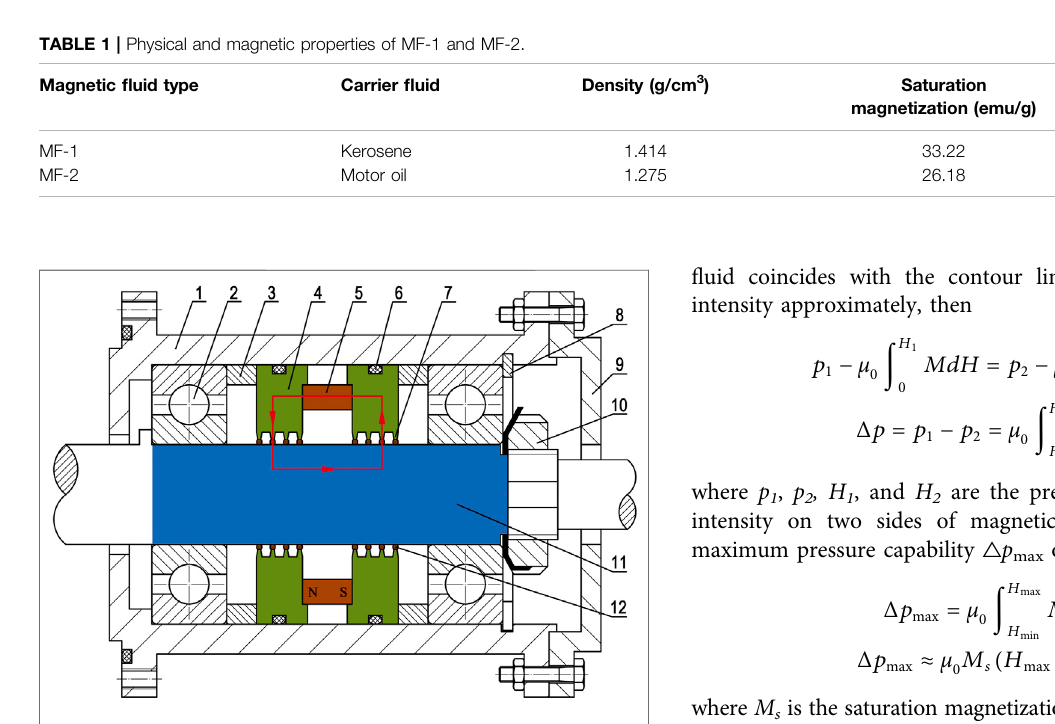
FIGURE2| SchematicrepresentationofatypicalMFSstructure(1-shell, 2-bearing, 3-sleeve, 4-pole piece, 5-magnet, 6-rubber ring, 7-pole tooth, 8- elastic collar, 9-end cover, 10-round nut, 11-shaft, and 12-magnetic fl uid).